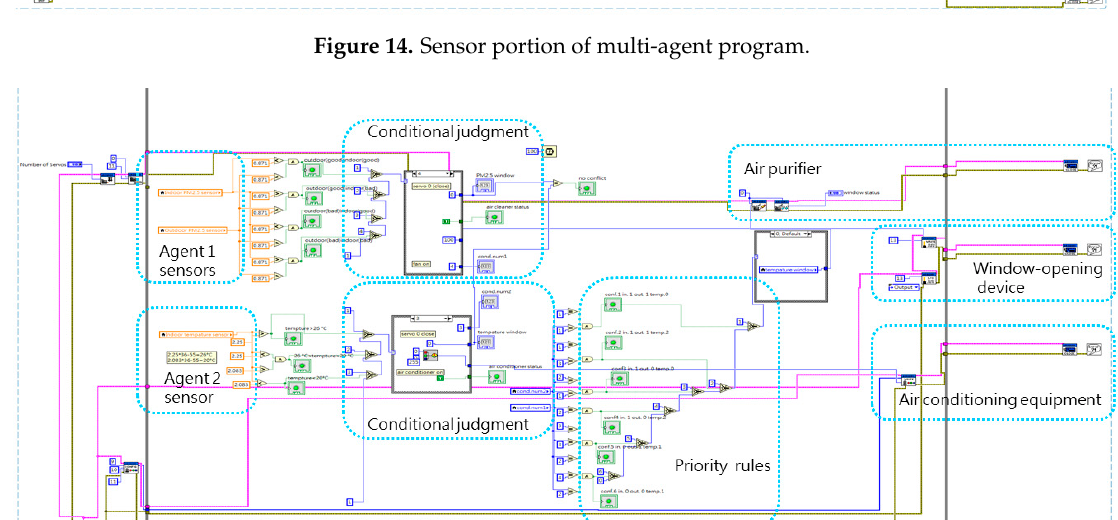
Figure 15. Intelligent agent and actuator portions of the LabVIEW program.